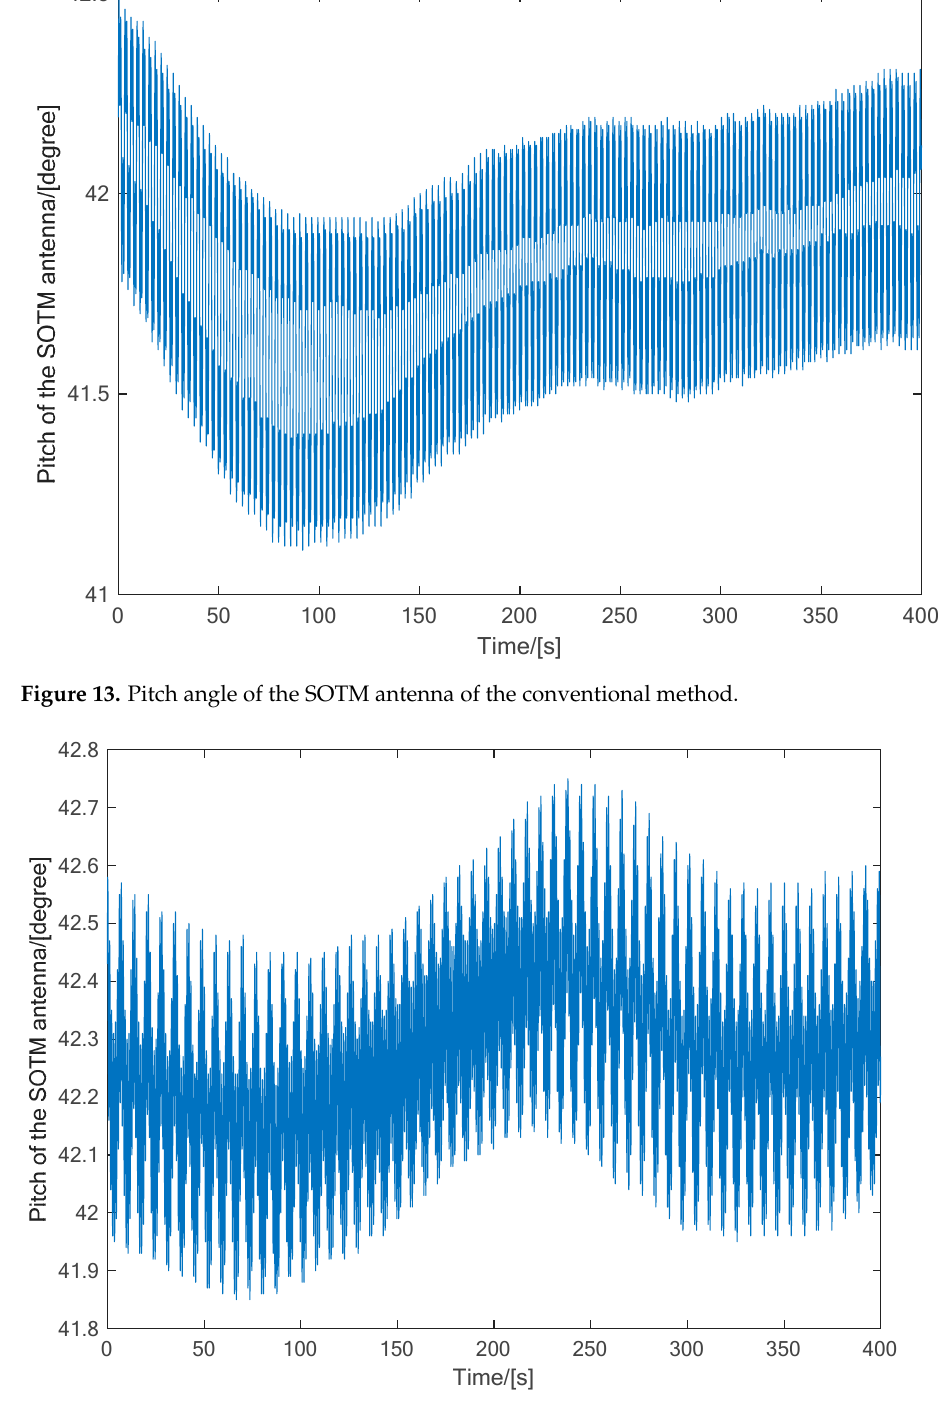
Figure 14. Pitch angle of the SOTM antenna of the method in this paper.